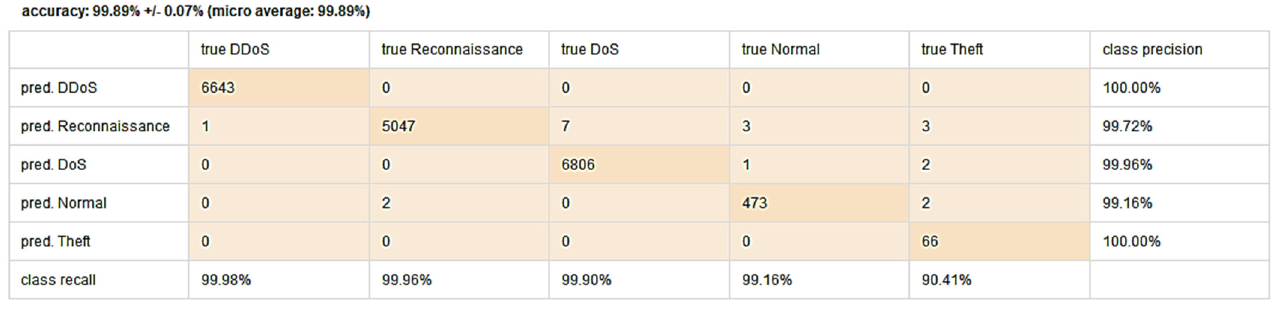
Figure 8. Confusion matrix of kNN-FS.